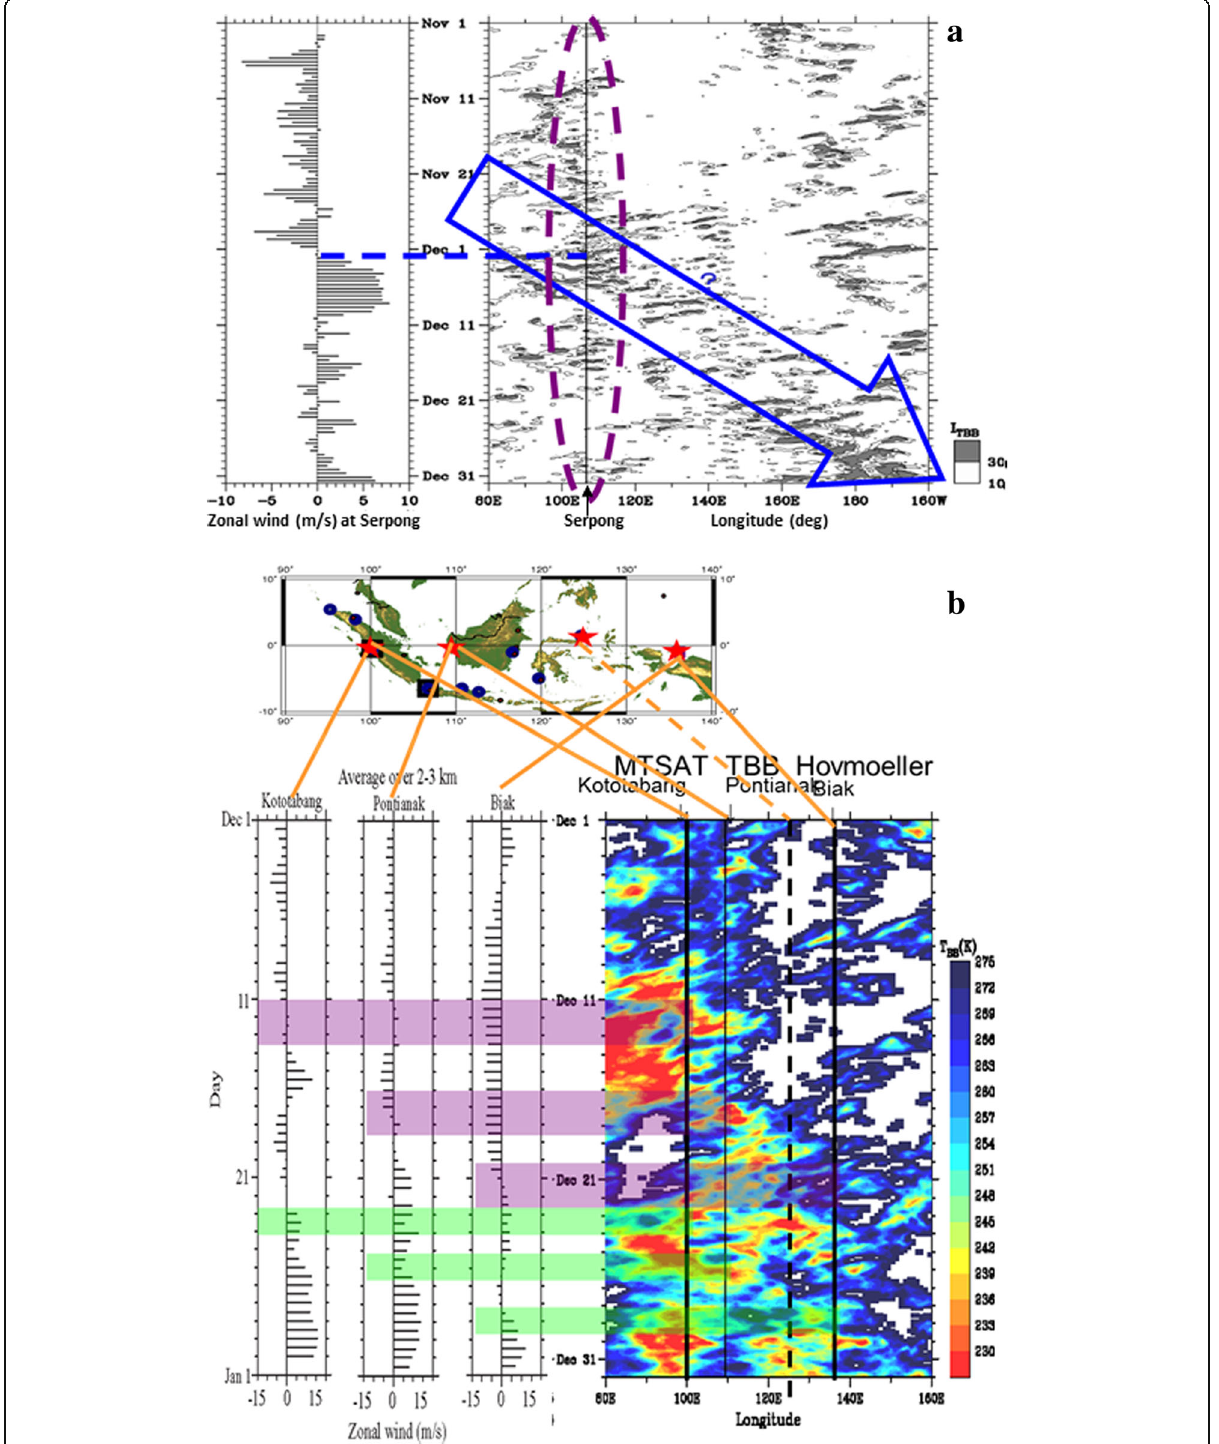
Fig. 5 ISVs arriving at the IMC a around the time of rainy season onset (November – December 1992) observed by a wind profiler (12 h averaged) at Serpong (6° S, 107° E) (left) and a GMS (hourly) Hovmöller diagram along 6° S (right) (Hashiguchi et al. 1995) and b during a rainy season (December 2007) by a wind profiler network at Kototabang (0° S, 100° E), Pontianak (0° S, 110° E), and Biak (1° S, 136° E) (map and left three panels) and GMS along the equator (right) (Yamanaka et al. 2008), showing modification/decay (smaller hierarchies associated with reversals in profiler zonal winds) mainly due to the diurnal cycle (appearing in GMS clouds) over the